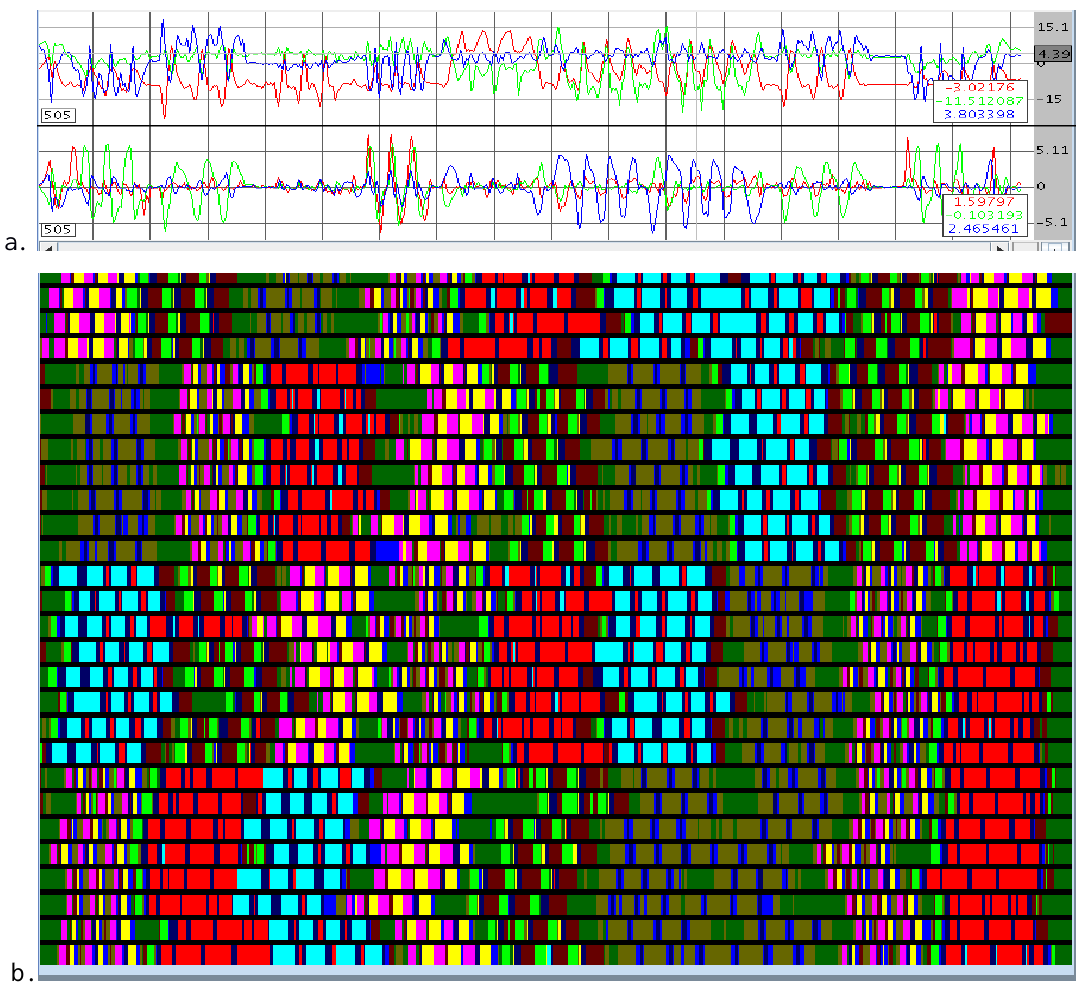
Figure 3 . Discovering individual exercises in exercise sessions. (a) The user’s wrist movements as measured by a 3-axis accelerometer and a 3-axis gyroscope are analyzed to discover repeated motifs. (b) These motifs are shown via unique colors in each of the 32 recorded exercise sessions. This simple visualization reveals the patterns of motifs that correspond to the six different exercises